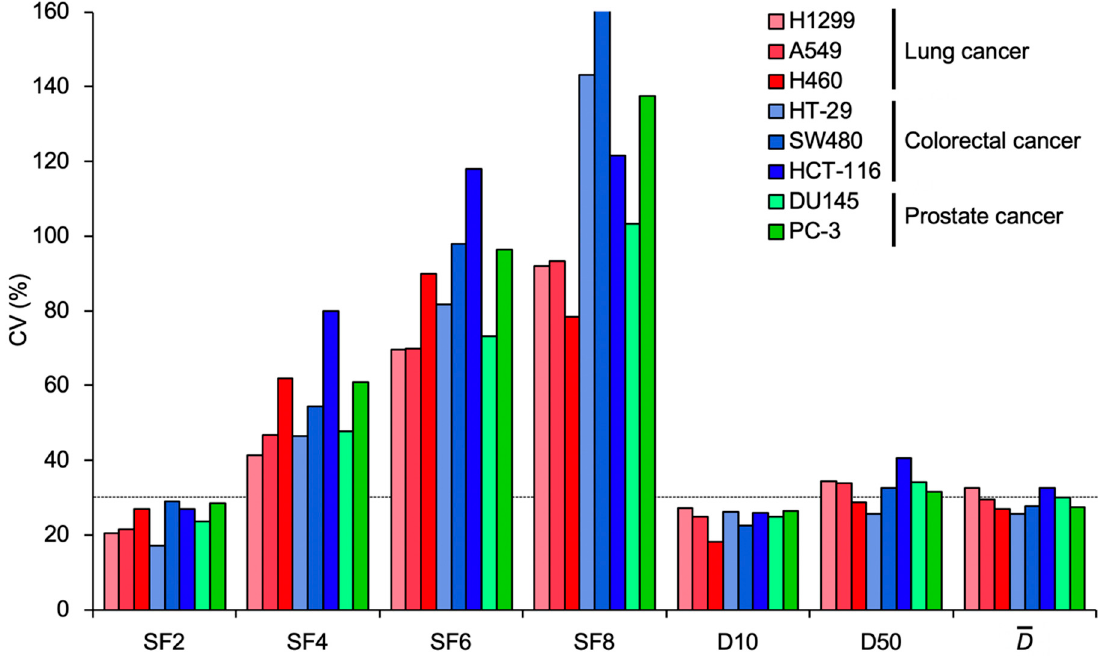
Figure 3. CV values of clonogenic survival endpoints for the cancer cell lines. The dashed line indicates a CV of 30%.